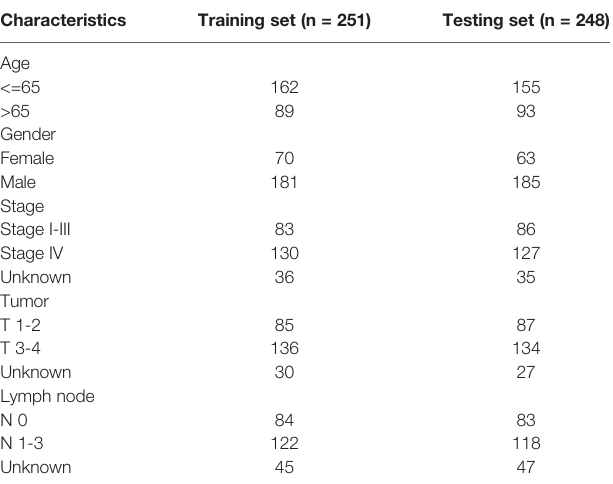
TABLE 1 | Basic clinical information of training set and testing